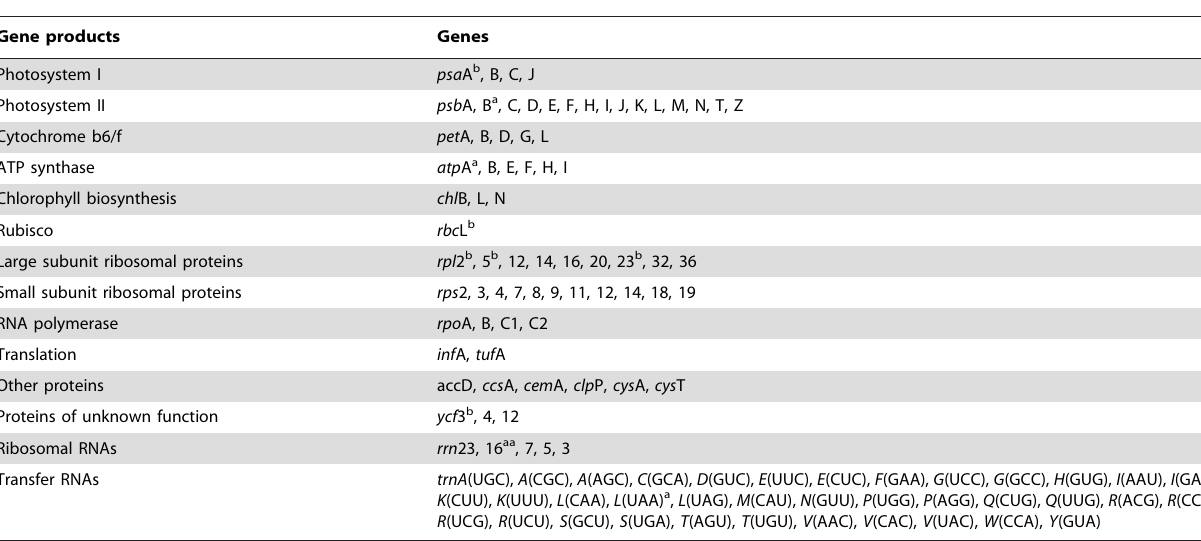
Table 1. Genes contained in B. hypnoides chloroplast